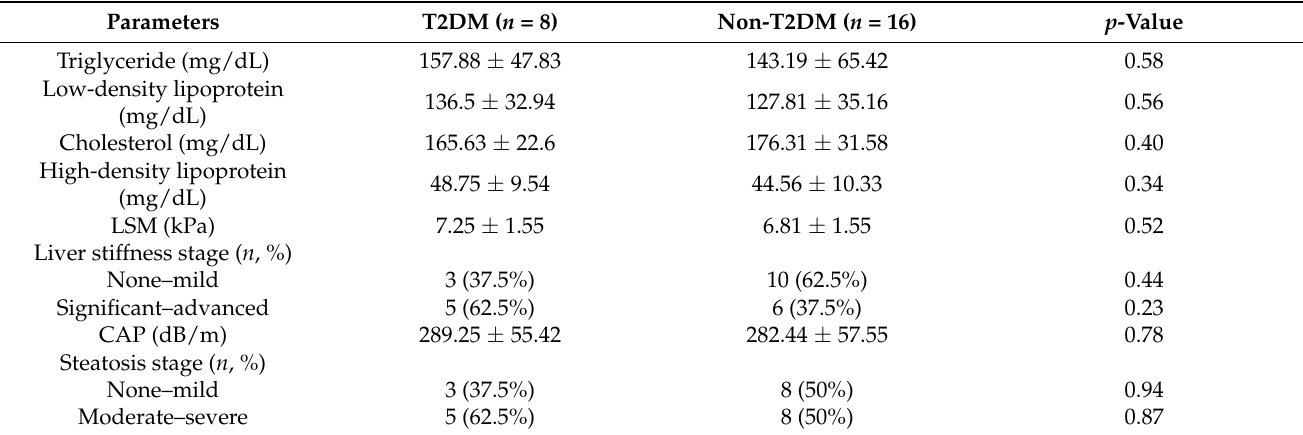
Table 2. Baseline characteristics of the obese group with or without T2DM comorbidity.